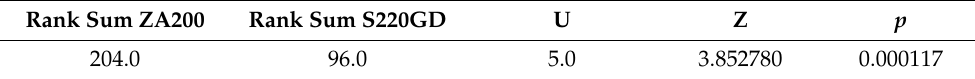
Table 3. Results of the Mann–Whitney (M-W) U -test.